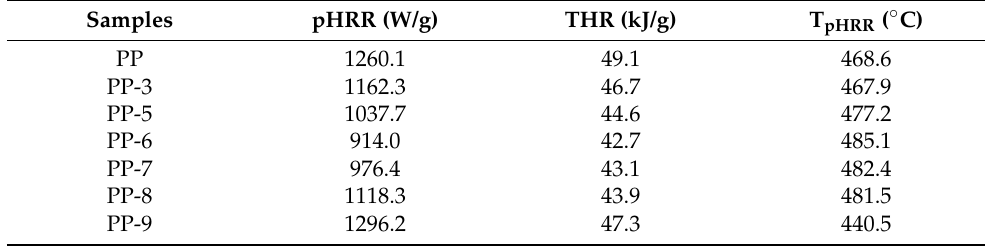
Table 2. Combustion parameters of PP and flame-retarded PP composites obtained from MCC tests. Samples